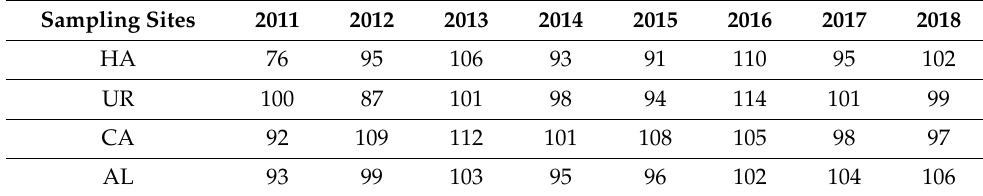
Figure 1. Geographical distribution of the selected monitoring sites of the air quality network from the Costa Rican metropolitan area. Table 2. Sample distribution for each site, 2011 −